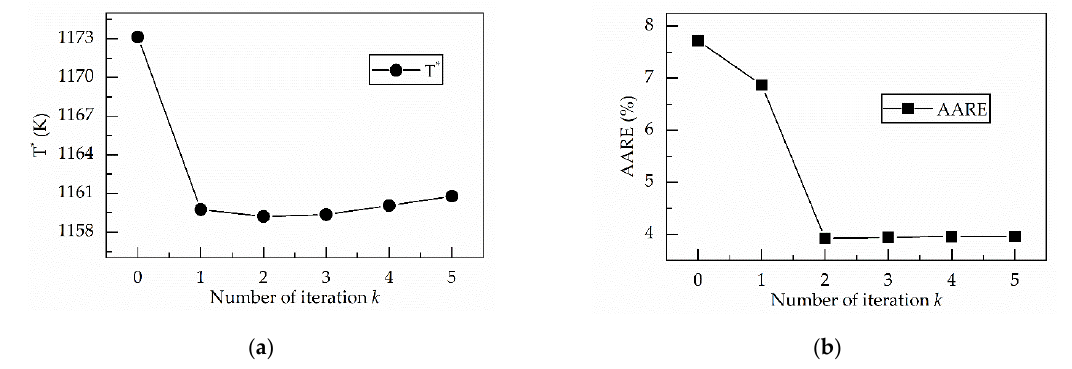
Figure 11. Based on the process in Figure 10, Variation of parameters ( a ) α ; ( b ) R 2 with the numbers of iterations k while optimizing the material constants under strain of 0.30.